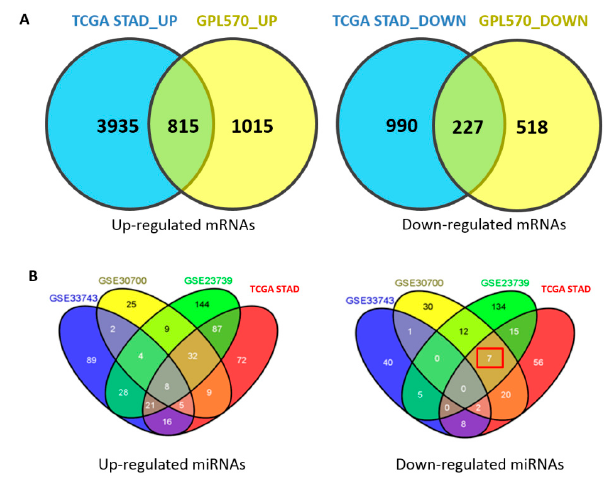
Figure 2. Differentially expressed genes and miRNAs in gastric cancer. ( A ) Up-regulated and down-